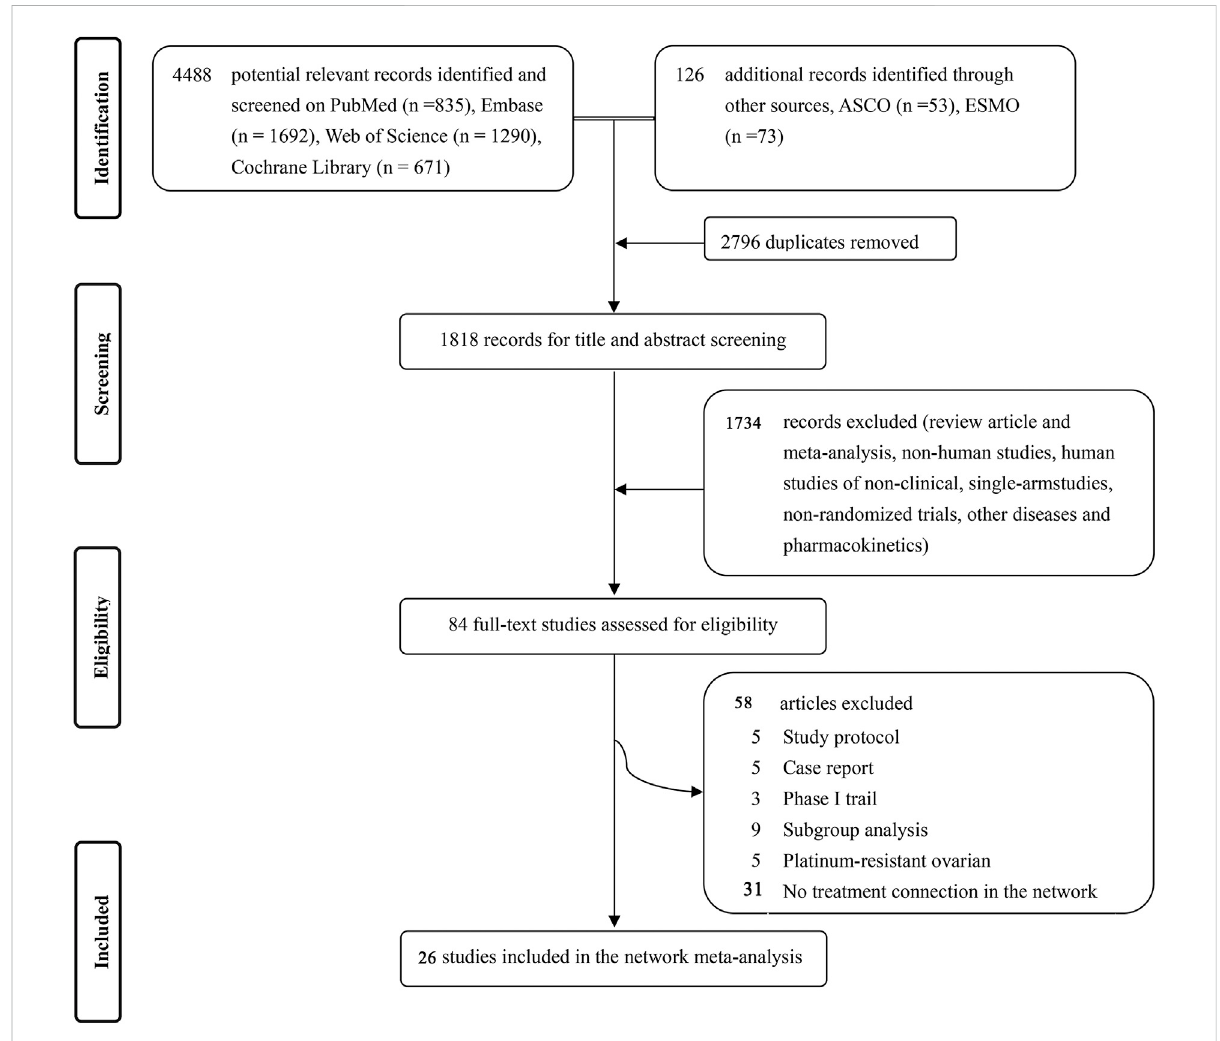
FIGURE 1 Flowchartofstudiesselectionanddesign(PRISMAchart).ASCO=AmericanSocietyofClinical Oncology.ESMO=EuropeanSocietyofMedical